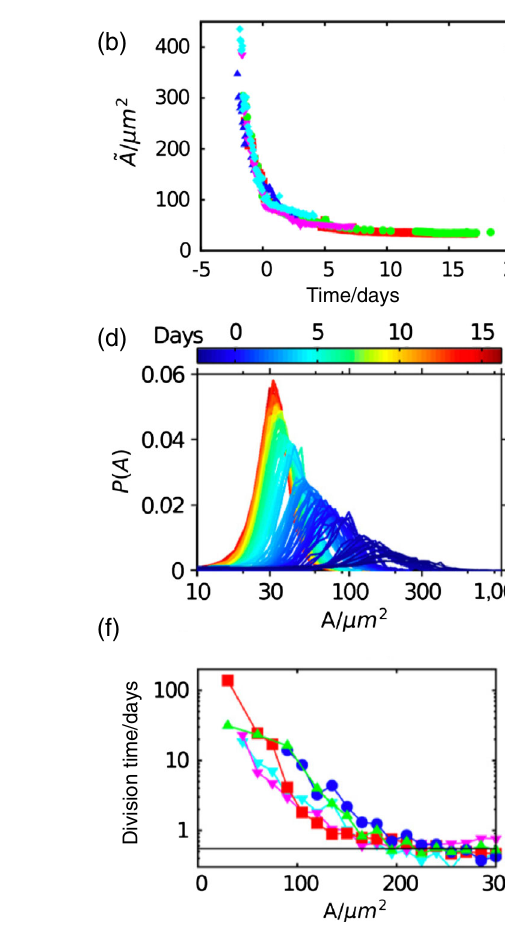
FIG. 7. Cell area distributions in MDCK cells are reproduced in our simulations. (a),(c),(e) Simulation results; (b),(d),(f) experimental results on spreading MDCK cells, reproduced with permission from A. Puliafito et al ., [12]. Panels (a) and (b) show the evolution of ˜ A as a function of time. In (a) we set t ¼ 0 as the crossover from exponential to subexponential growth colony-average median cell area of the colony area, roughly 20 τ after initialization. In (b) time t ¼ 0 is measured from a “ morphological transition ” that is close to the div crossover to subexponential growth, noting that substantial changes in cell thickness were reported before this time; see Ref. [12] for details. These thickness changes mean that comparison with quasi-2D simulations (a) only becomes appropriate for t ≳ 0 . Panels (c) and (d) show the colony-wide probability distribution of individual cell area at different times (colors). Panels (e) and (f) show the distribution of the time between cell division events as a function of the premitotic area. In (e) every cell division event contributes a data point while in (f) data points with division times greater than 3 days are inferred indirectly. In (f) the five different datasets (colors) are from different experiments. See Ref. [12] for details. We choose simulation parameters to roughly match those of the MDCK